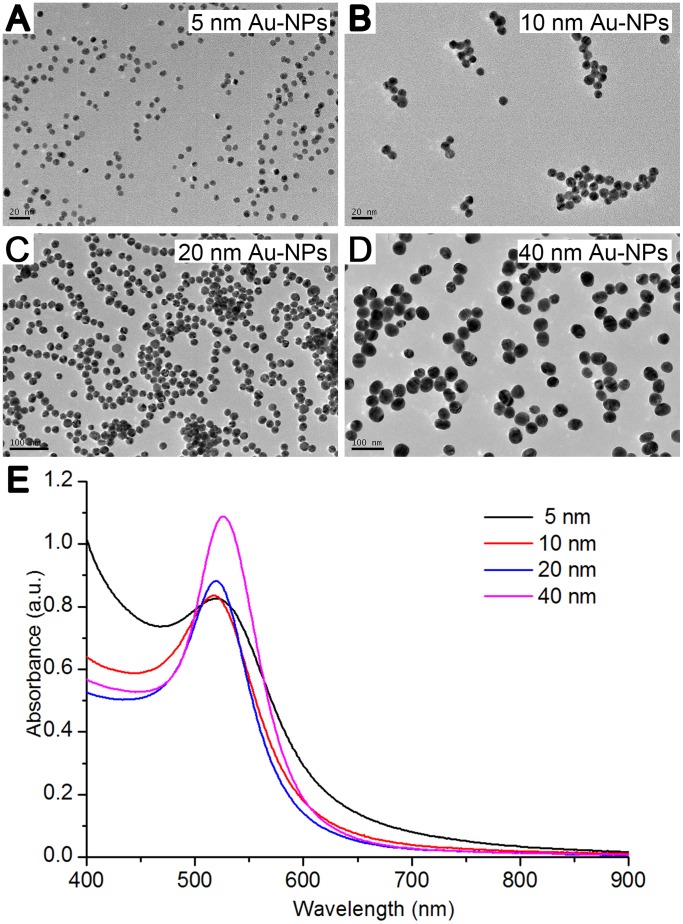
Characterization of the differently sized Au-NPs.Transmission electron microscopy (TEM) images of Au-NPs with diameters of (A) 5 nm, (B) 10 nm, (C) 20 nm, or (D) 40 nm. The insets show high-resolution images. Scale bars, 20 nm and 100 nm (as marked). E: UV-vis spectra of the Au-NPs with 5-nm, 10-nm, 20-nm, and 40-nm diameters.